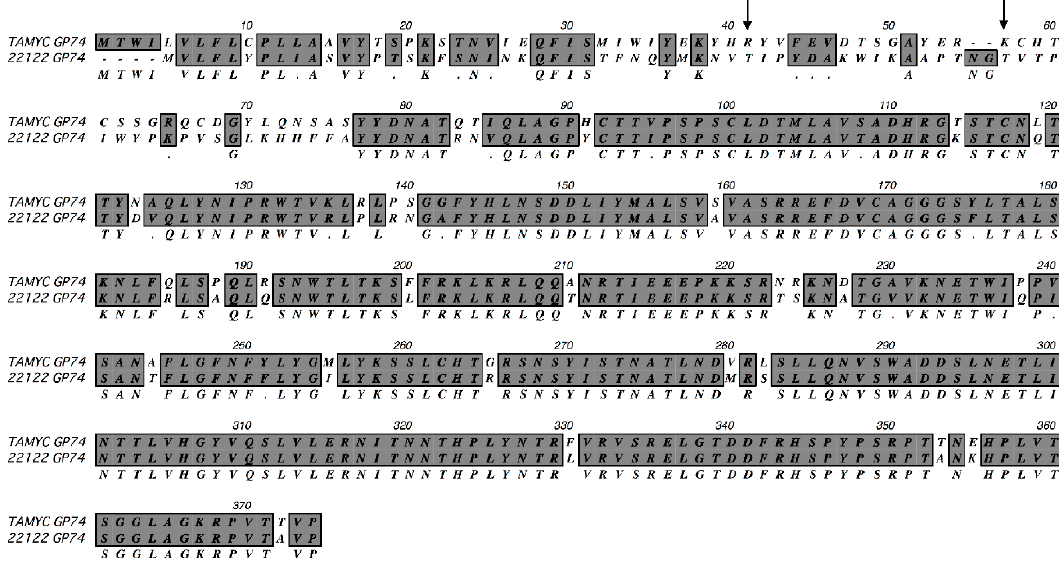
Figure 1. ClustalW protein alignment of TAMYC GP74 (gO). ClustalW alignment of predicted amino